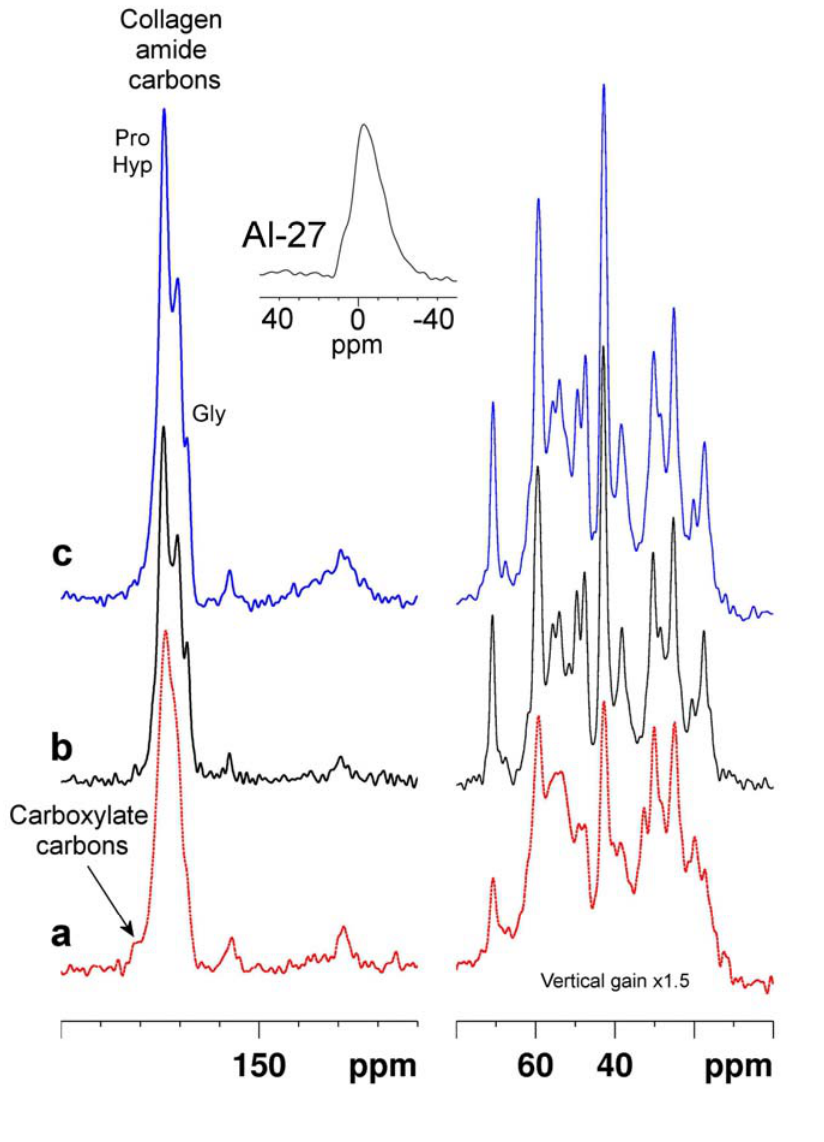
Figure 4. Solid state 13 C CP-MAS spectra of untanned hide (a, red dotted trace) , and identically acquired spectra of aluminium sulphate tanned leather (b, black trace), and glutaraldehyde tanned leather in which the resolved backbone amide glycyl and prolyl/hydroxyprolyl signals are marked (c, blue trace) . The inset is a 27 Al Hahn spin echo spectrum of the Al (III) tanned